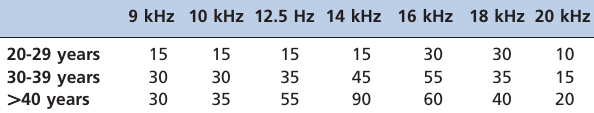
Table 2 - Normality cutoff values in high-frequency audiometry (in dB HL) by frequency and age